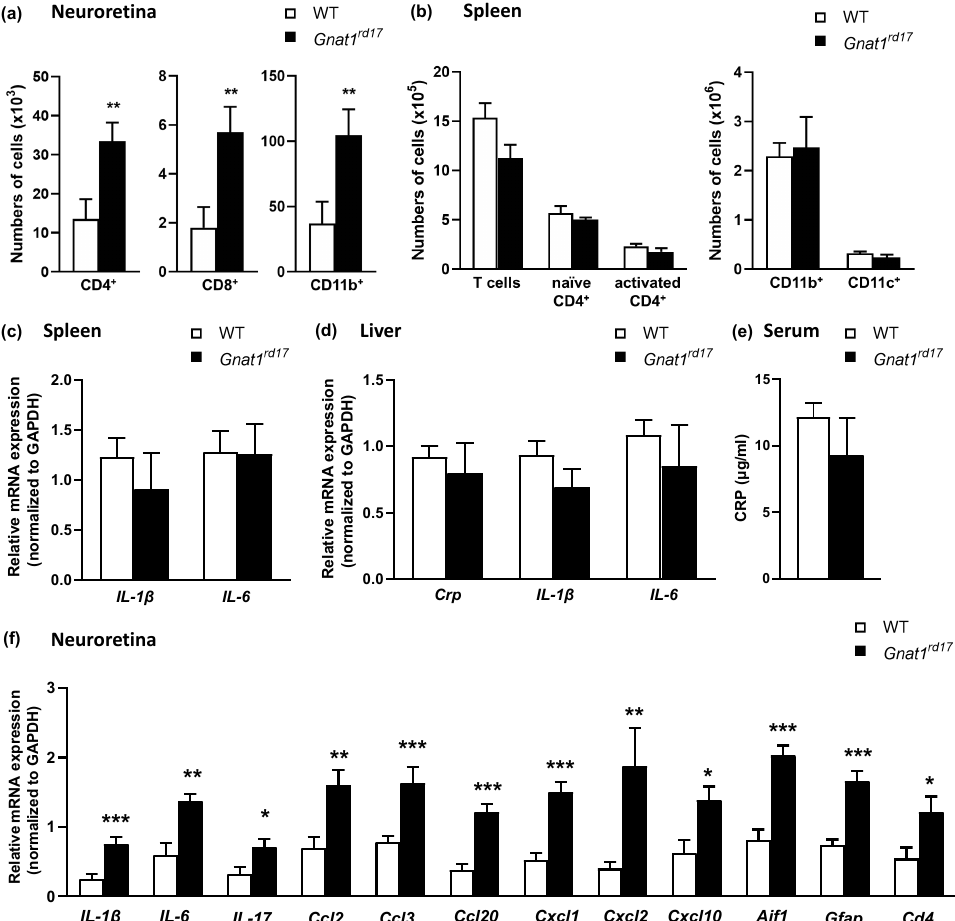
Figure 2. EAU in Gnat1 rd17 mice results in an increased accumulation of immune cells in the neu- roretina accompanied by local overexpression of inflammatory mediators. ( a ) Quantification of total CD4 + , CD8 + , and CD11b + cell infiltrates in the neuroretina by flow cytometry in EAU WT and Gnat1 rd17 mice on day 14 after immunization. Data are given as the mean ± SEM of 10 neuroretinas per group. Differences between groups: ** p < 0.01 by unpaired t -test. ( b ) Flow cytometry analysis of splenocytes collected from EAU WT and Gnat1 rd17 mice on day 14 after immunization shows no statistically significant difference between the groups for total numbers of CD3 + T cells, naïve CD4 + T cells (CD4 + CD44 low ), activated CD4 + T cells (CD4 + CD44 high ), CD11b + (CD11b high CD11c low , macrophages, and neutrophils), or CD11c + (CD11c high MHC-II high , dendritic cells). Data are shown as mean ± SEM of 5 mice in each group (unpair t -test). ( c ) Spleen mRNA expression of IL-1 β and IL-6 ; ( d ) liver mRNA expression of Crp , IL-1 β , and IL-6 ; and ( e ) serum CRP levels show no statistically significant difference between WT and Gnat1 rd17 mice on day 14 after immunization. Data shown are the mean ± SEM of 5 mice in each group (unpaired t -test). ( f ) mRNA levels of cytokine, chemokine, and neuroinflammatory/immune cell marker genes in the neuroretinas of EAU WT and Gnat1 rd17 mice on day 14 after immunization. The data are presented as the mean ± SEM of 8–10 neuroretinas from 4–5 mice per group, with one representative of two experiments shown. Significant differences between groups: * p < 0.05, ** p < 0.01, and *** p < 0.001 (unpaired t